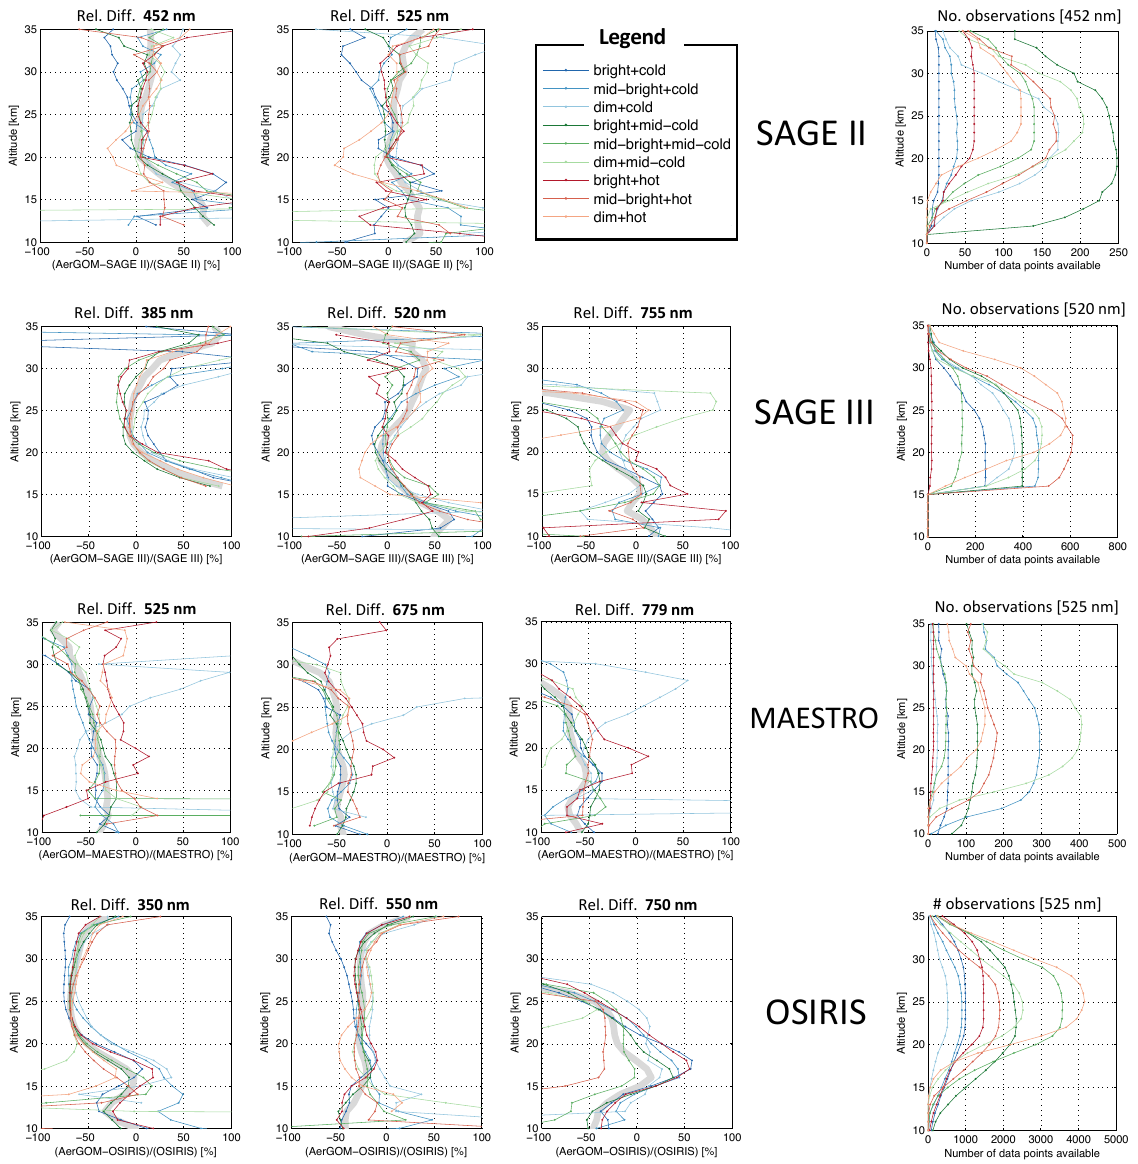
Figure 7. Relative differences between AerGOM and SAGE II, SAGE III, MAESTRO and OSIRIS datasets for different star categories, ranging from dim–cold to bright–hot (left panels). The rightmost panel presents the number of observations for each dataset comparison and star